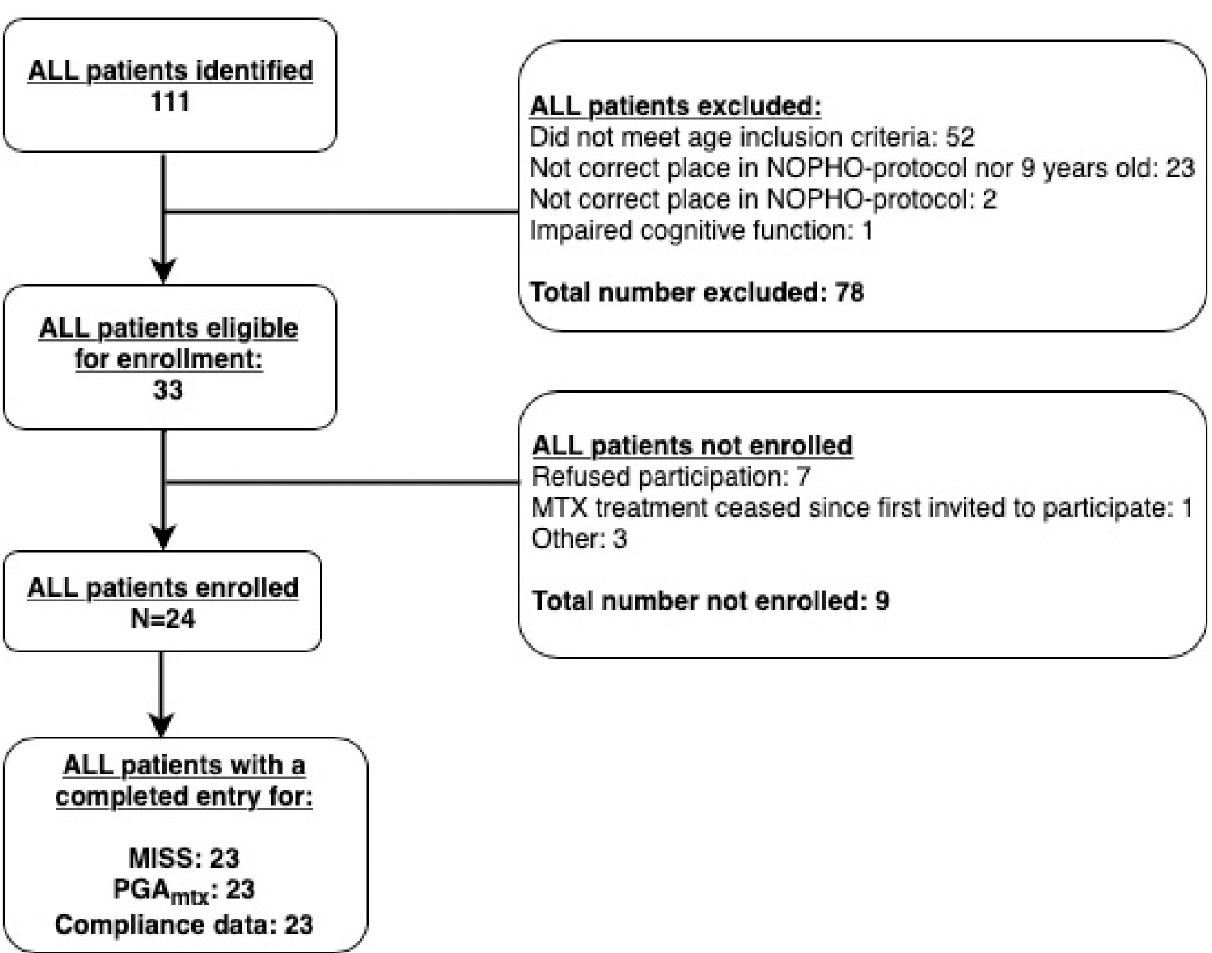
Fig 2. The acute lymphoblastic leukaemia study population. Flowchart showing the enrolment and exclusion of patients within the acute lymphoblastic leukaemia (ALL) study population. NOPHO = Nordic Society of Paediatric Haematology and Oncology. MTX = low-dose methotrexate; MISS; Methotrexate intolerance severity score. PGA mtx ; Physician’s global assessment of MTX intolerance.